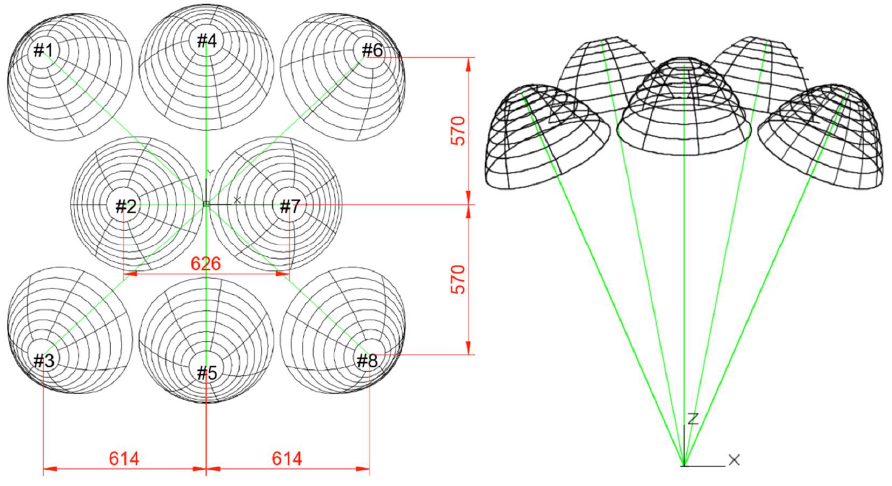
Figure 2. Top view and front view of the HFSS (dimensions in mm).